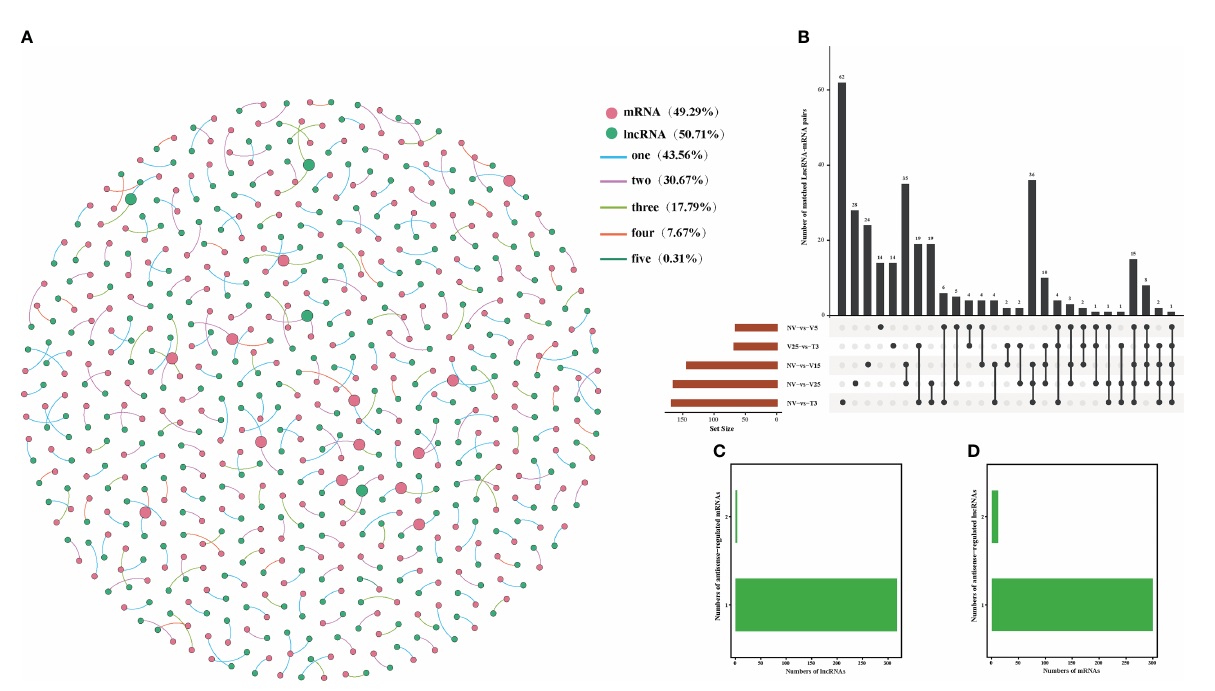
FIGURE 4 Interactions between DE lncRNAs and anti-regulated DE mRNAs during plumule-vernalization in Chinese cabbage. (A) The DE lncRNA – mRNA interaction network of fi ve comparisons (NV-vs-V5, NV-vs-V15, NV-vs-V25, NV-vs-T3, and V5-vs-T3). The nodes represent the mRNAs (red) and lncRNAs (green). The size of the nodes is positively related to the number of mRNAs (lncRNAs) associated with lncRNAs (mRNAs). The color of the line indicates that a relationship exists in several comparison groups (1/2/3/4/5). (B) Venn diagram showing the number of matched lncRNA – mRNA pairs in different comparisons. (C) The number of DE mRNAs regulated by DE lncRNAs. (D) The number of DE lncRNAs that have potential anti- regulatory effects on DE